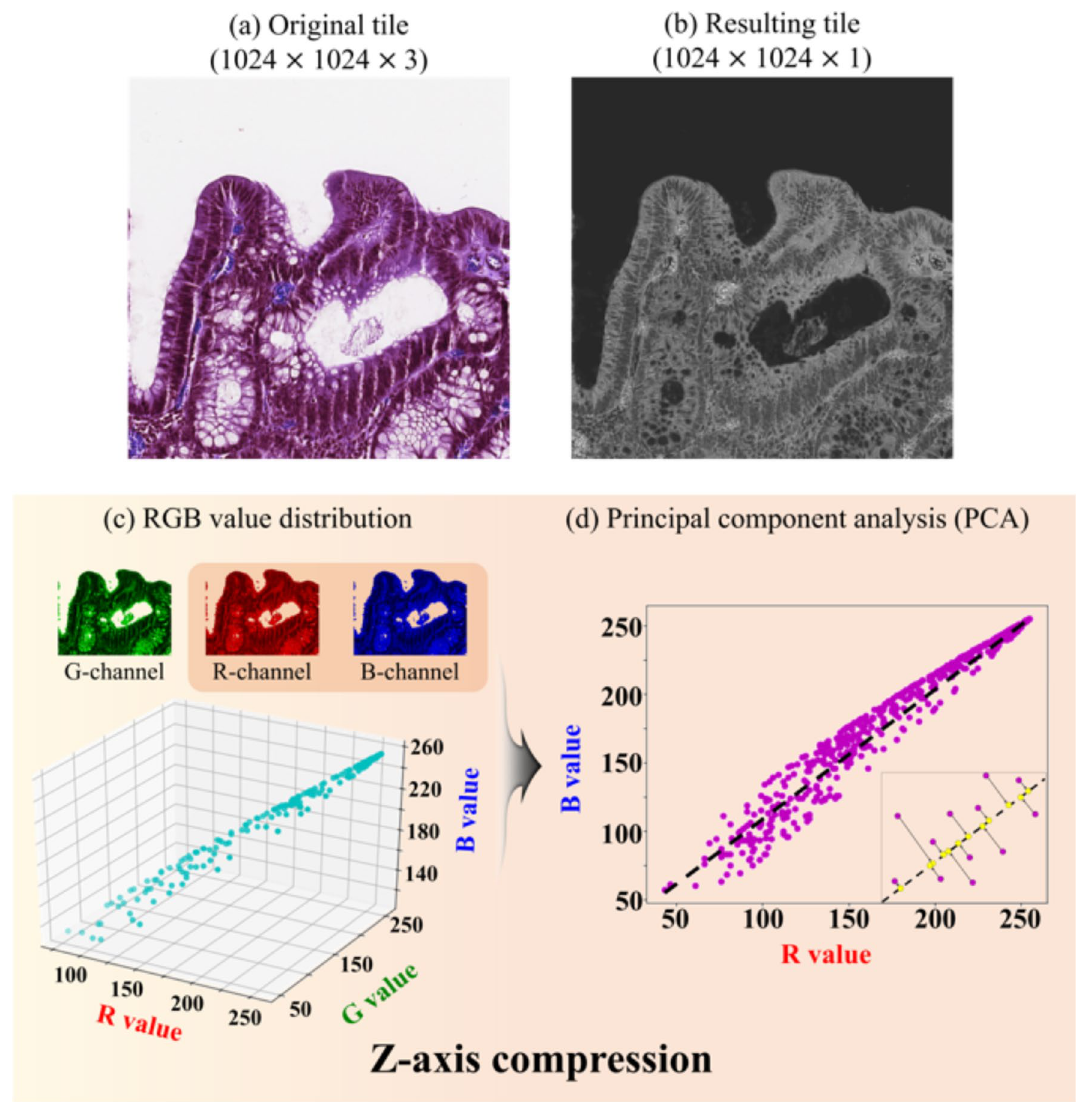
( d ) The PCA for the R and B